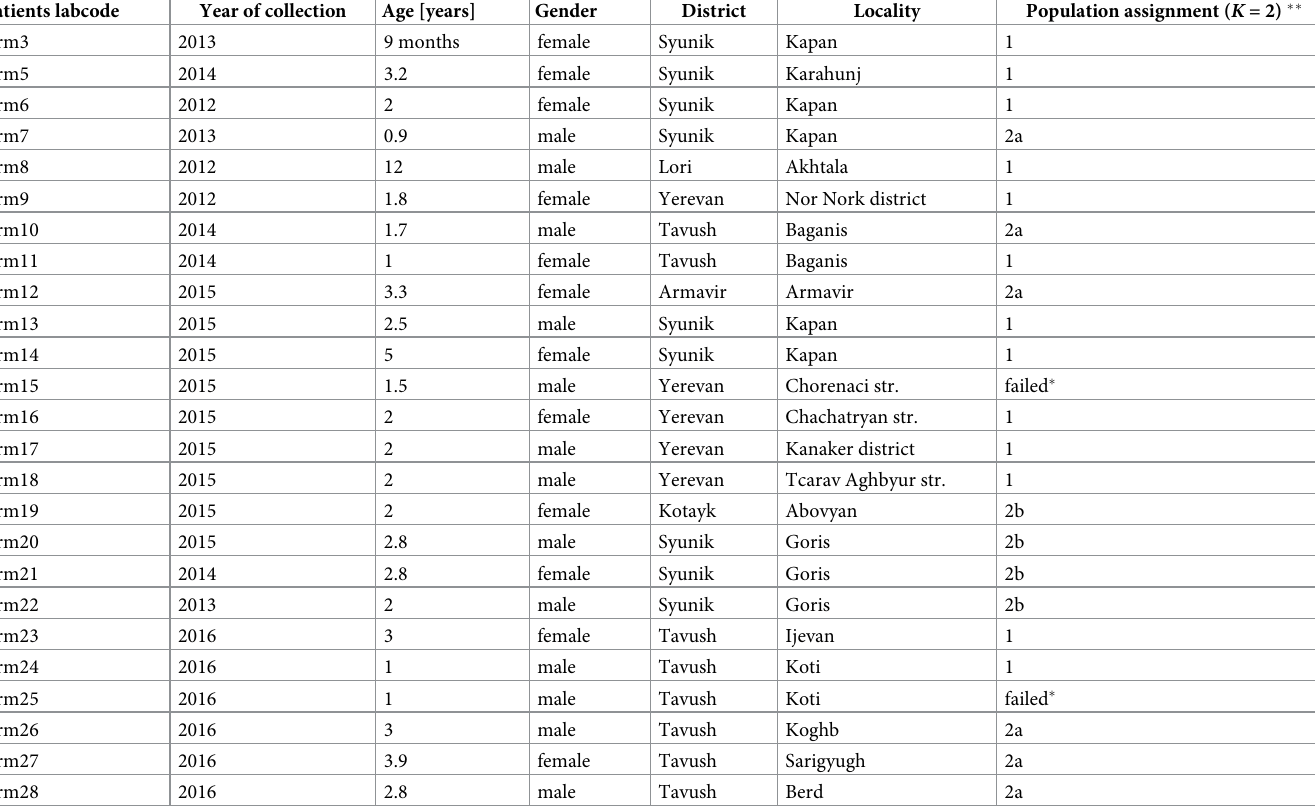
Table 1. Designation, patient characteristics, geographic origin and population assignment by MLMT of the studied Armenian L . infantum samples. Patients labcode